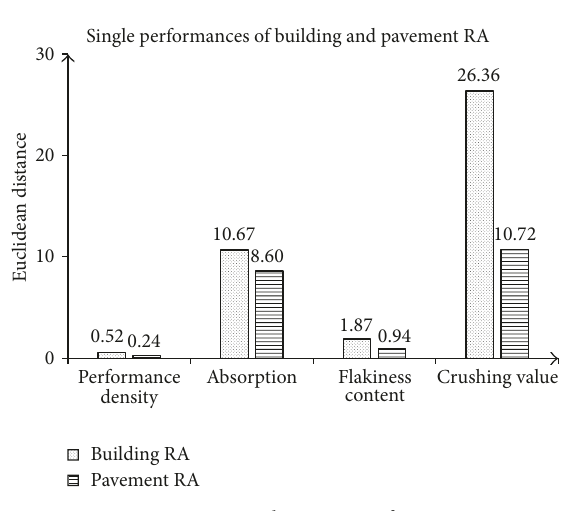
Figure 5: Single property of RA.